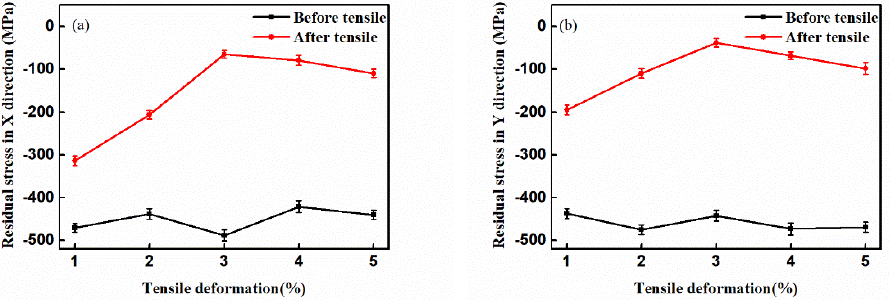
Figure 3. Residual stress of GH4169 alloy samples before and after tensile treatment: ( a ) Residual stress in X direction; ( b ) Residual stress in Y direction. (The picture has been replaced with a higher quality)